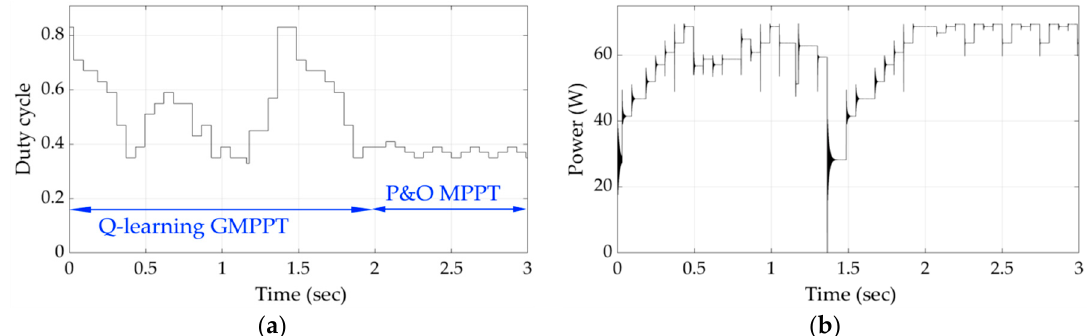
Figure 14. Results during execution of the proposed Q-learning-based GMPPT process for shading pattern 7: ( a ) duty cycle versus time and ( b ) PV array output power versus time.